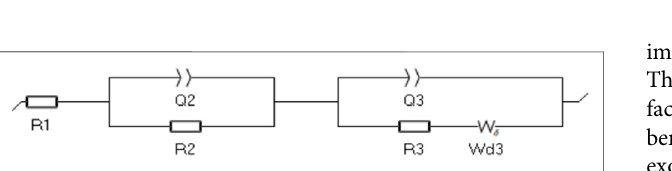
FIGURE 1 | Nyquist and Bode plots for inoculation and growth phases of MEC development. The ECM fi t is included as a solid line overlaid on the raw data.